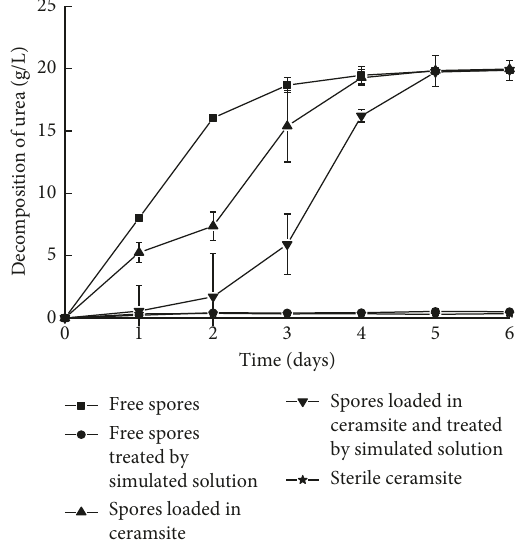
Figure 4: Urea decomposition by free spores and loaded spores with or without treatment by high-pH-simulated